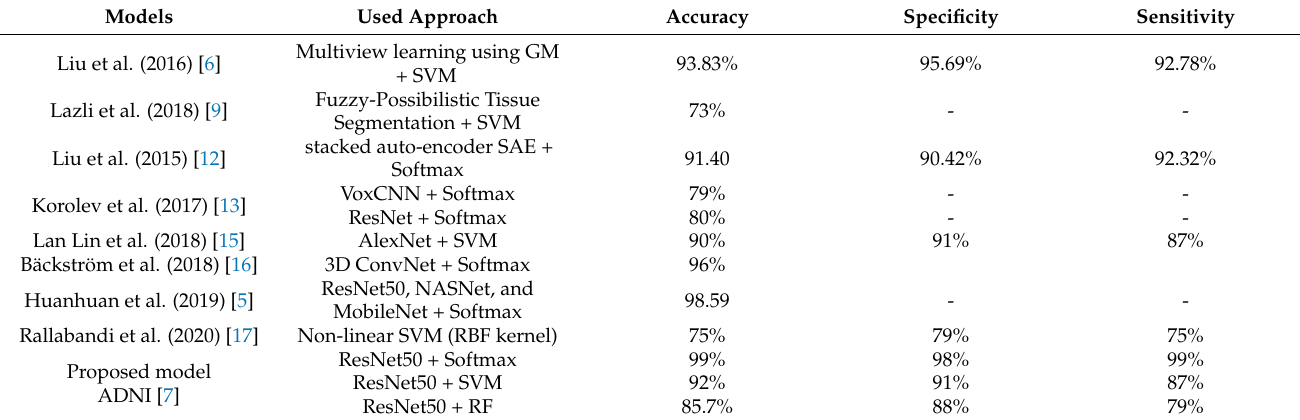
Table 6. Comparison of our test performance with eight existing state-of-the-art methods.